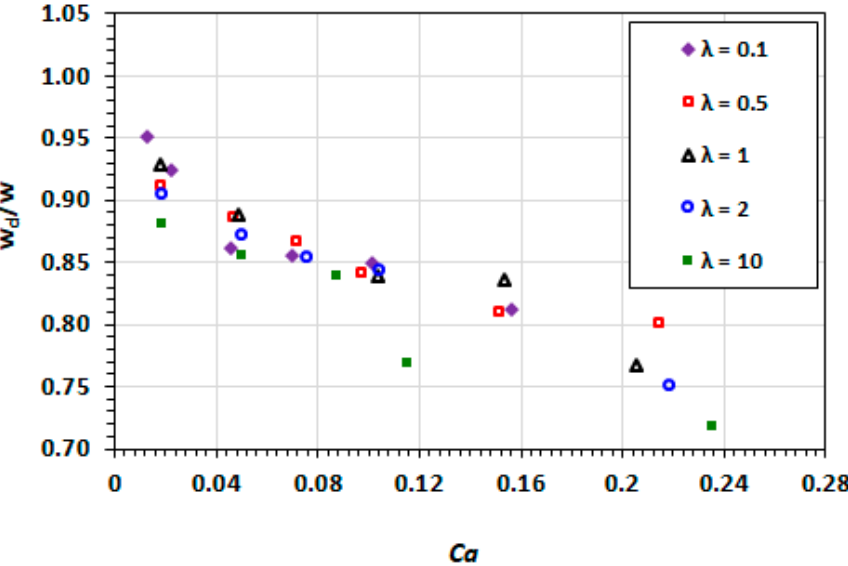
Figure 11. Dependence of the non-dimensionalised droplet width on capillary number at varying viscosity ratios .